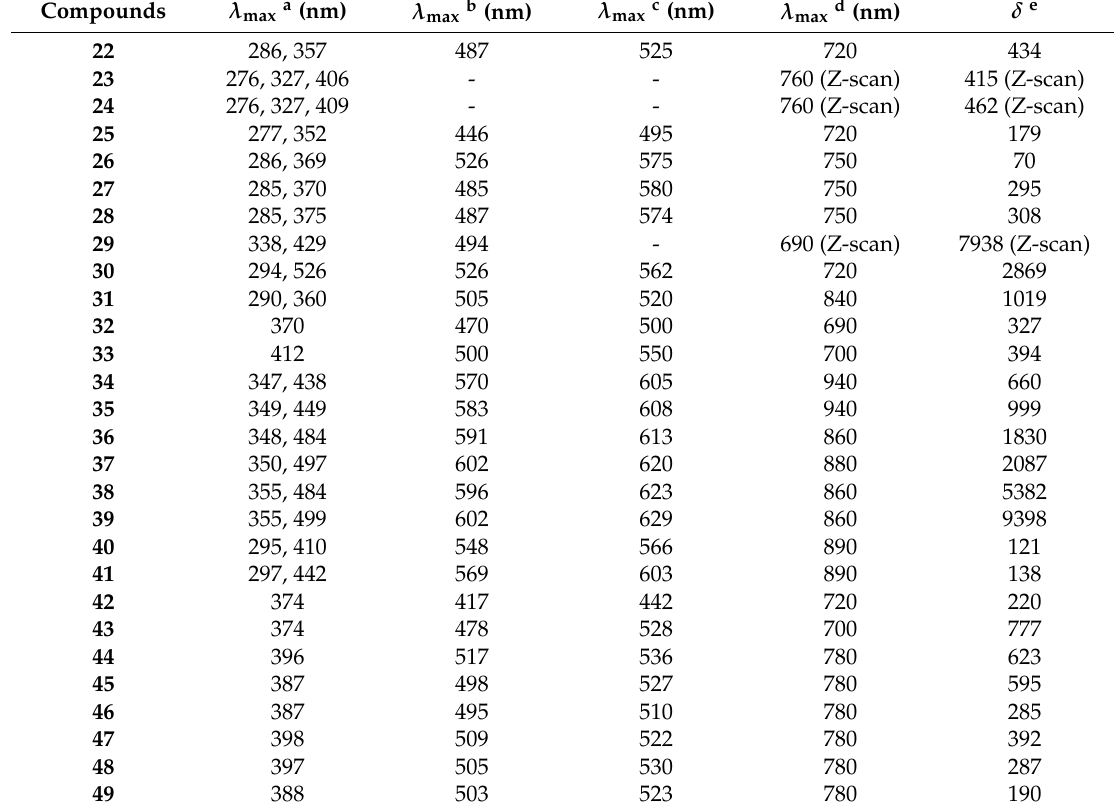
Table 3. Photophysical data of 22 – 49